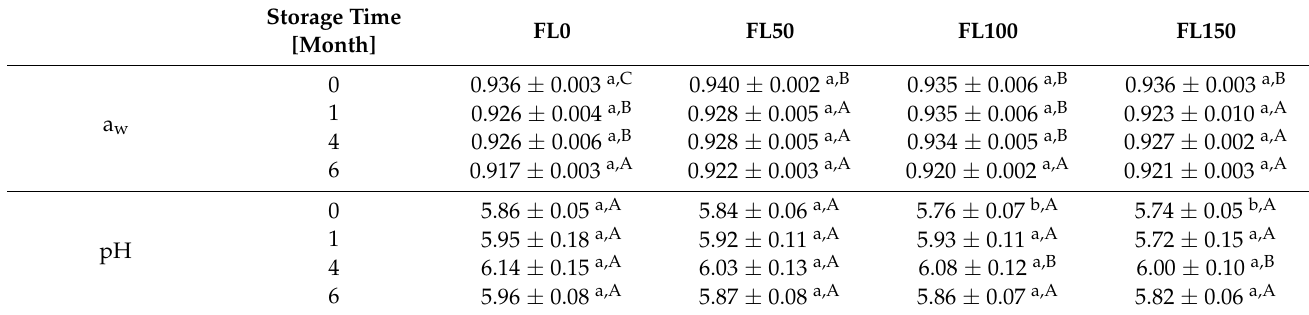
Table 4. pH and water activity of fermented loins during storage (mean ± standard deviation).